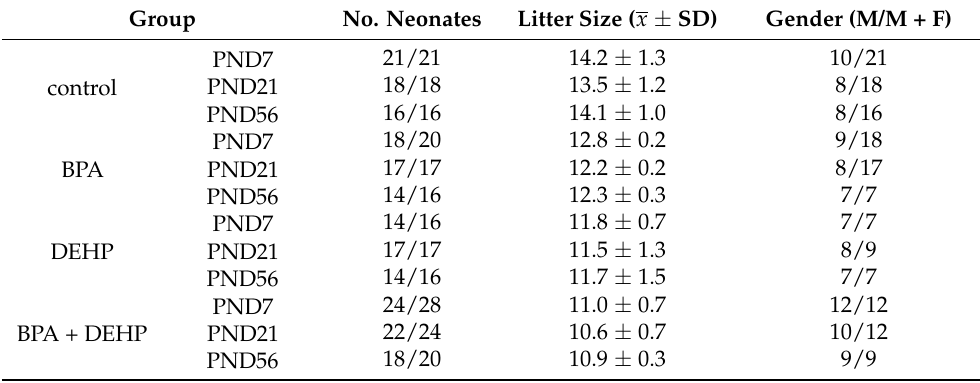
Table 1. Number of pregnancies, neonates born, average litter size, gender ratio of offspring born from rat dams following exposure to various